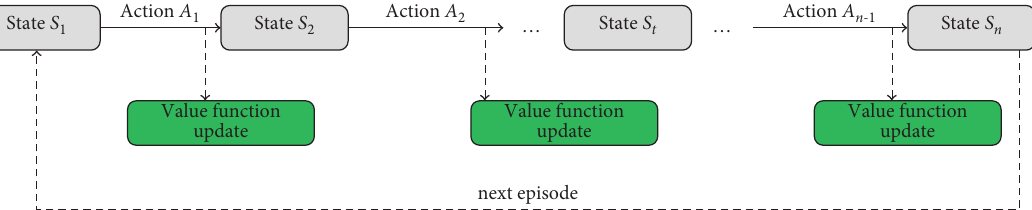
Figure 11: Temporal-difference learning